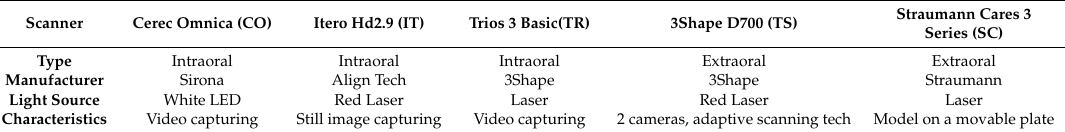
Figure 1. A Reference Master model. Table 1. Summary of characteristics for the scanning systems.